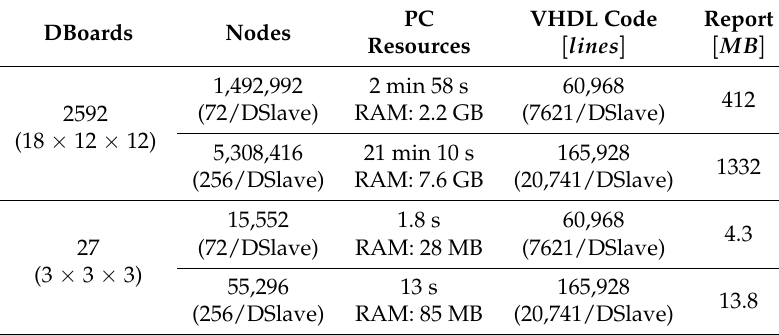
Table 3. DLLDesigner statistics.